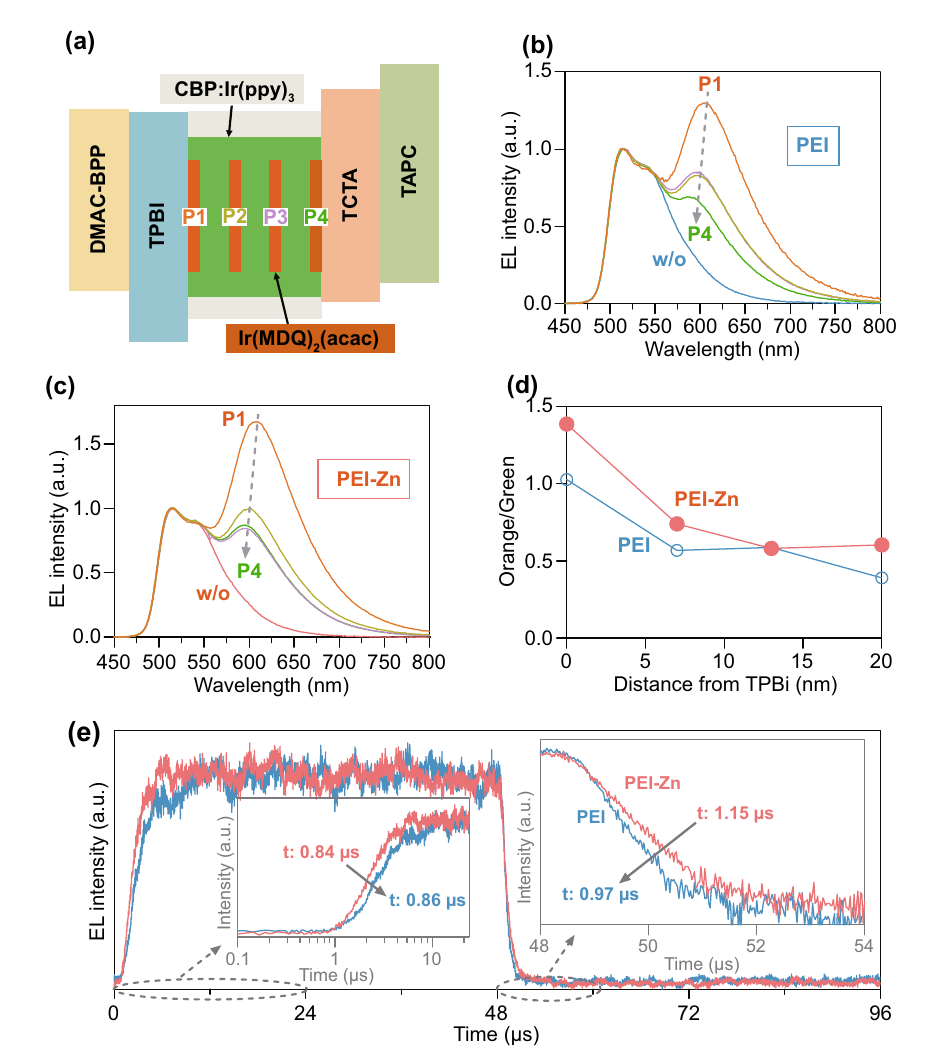
Fig. 4 a Schematic diagram of devices ( P 1 to P 4) with an orange probe at different distance from the TPBi/EML interface. EL spectra of b PEI‑ based devices and c PEI‑Zn‑based devices with the orange probe. d Ratios of orange emission to green emission for PEI‑based devices and PEI‑ Zn‑based devices with an orange probe. e Transient EL characteristics (@520 nm) of device PEI and device PEI‑Zn without the orange